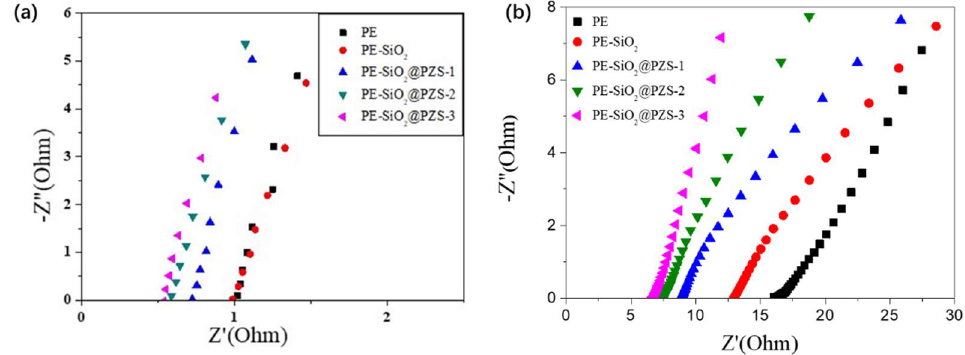
Figure 4. ( a ) The AC impedance spectrum responses of a stainless steel/separator/stainless steel sandwich structure for the PE membrane, PE-SiO 2 , PE-SiO 2 @PZS−1, PE-SiO 2 @PZS−2 and PE-SiO 2 @PZS−3 separators at room temperature. ( b ) AC impedance spectra for LiCoO 2 /Li batteries assembled with